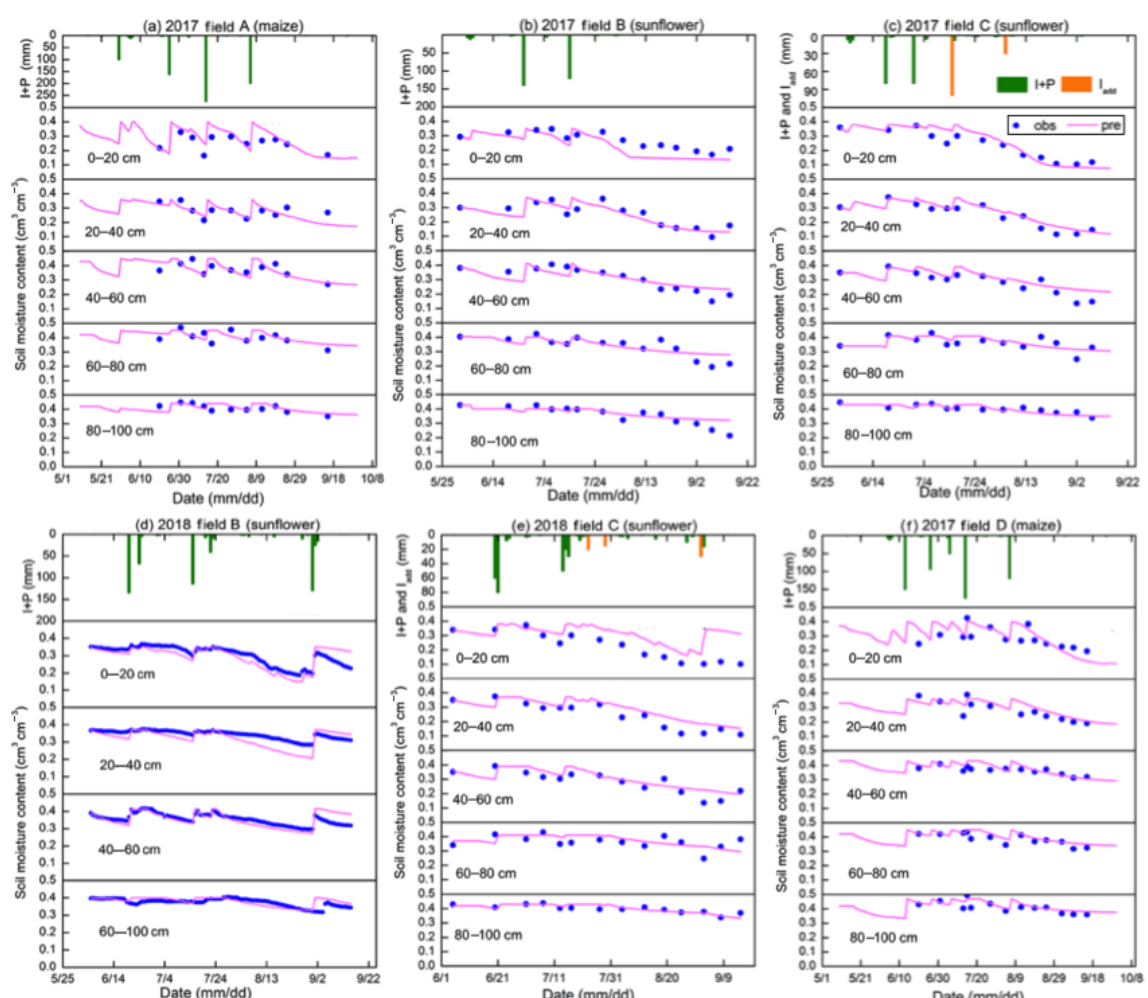
Figure 5. Observed (blue dots) and simulated soil moisture content of the Shahaoqu experimental fields during model calibration (a–c) and validation (d–f)